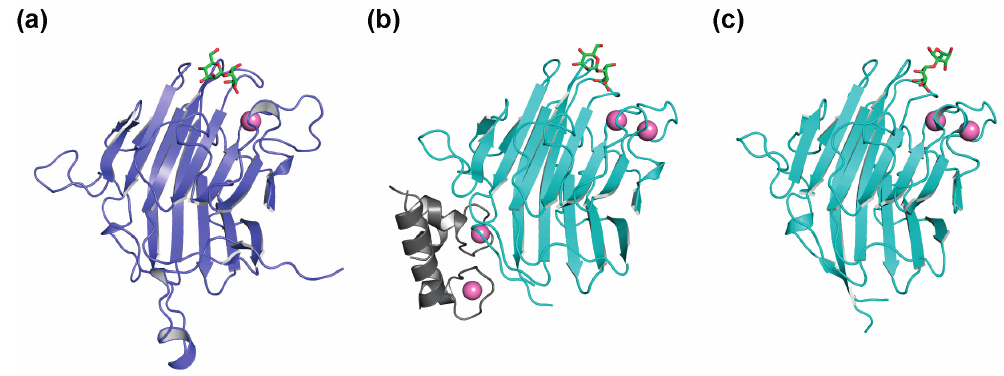
Figure 4. Ribbon models of the sugar-bound complexes of ( a ) VIP36 CRD (PDB code: 2DUR) [27]; ( b ) ERGIC-53 CRD –MCFD2 (PDB code: 3WNX) [29]; and ( c ) ERGIC-53 CRD (PDB code: 4GKX) [28]. Bound α 1,2-linked mannobiose in the complex structures is represented in stick